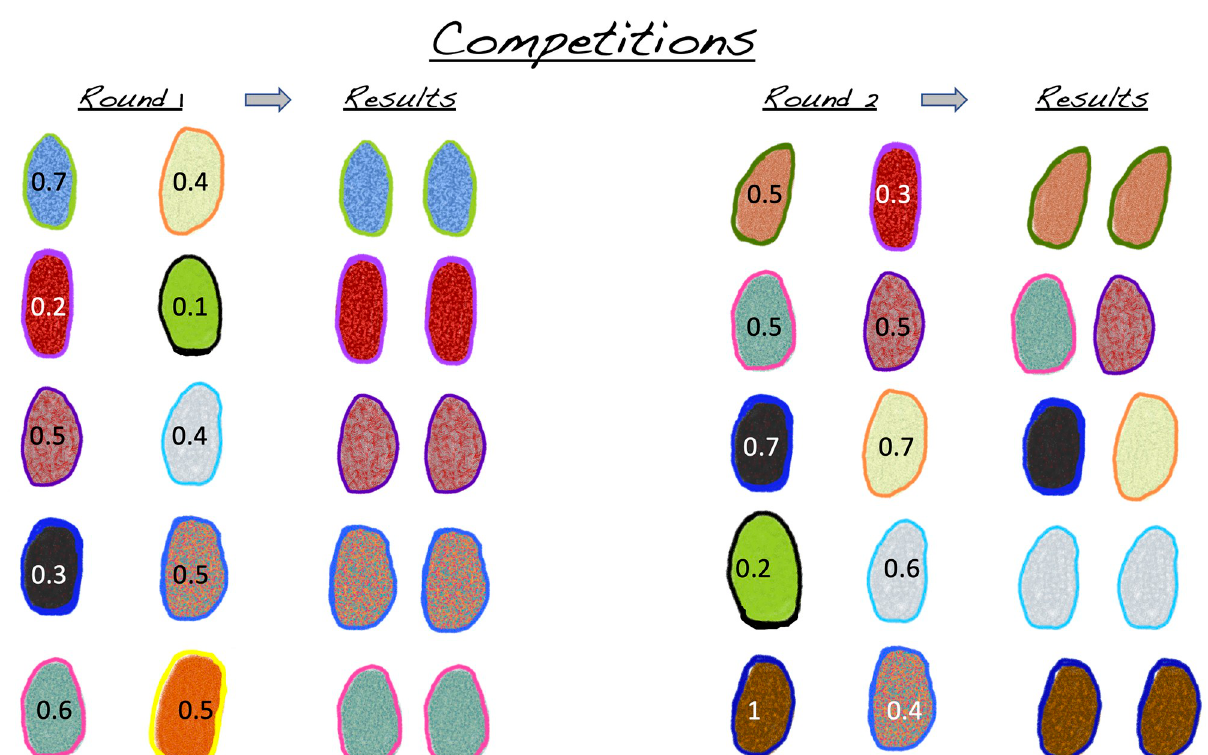
Fig 2. Phenotypically heterogeneous individuals compete. At each round of competition, a subset of diverse individuals from a large cohort competes and the outcomes of competition are assessed based on their relative competitive abilities (values within cells). Supported by empirical observations, the competitive ability of clonal individuals can be expressed heterogeneously in identical conditions and vary over time. Our work reflects this by assigning individuals their competitive ability according to the strategy of the species. Thus, variability amongst individuals and the phenotypically heterogeneous strategy of the species is